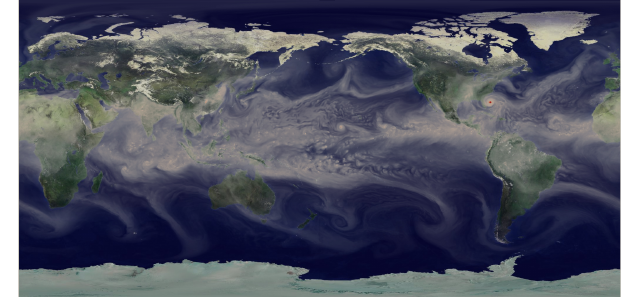
Figure 3. Visualization of total precipitable water, from a 0 . 125 ◦ ( n e = 240) E3SM simulation. The simulation used active atmo- sphere, land and ice component models, with prescribed ocean sea surface temperature and prescribed sea ice extent. Dynamics in HOMME alone accounts for roughly 1.6 billion degrees of free-